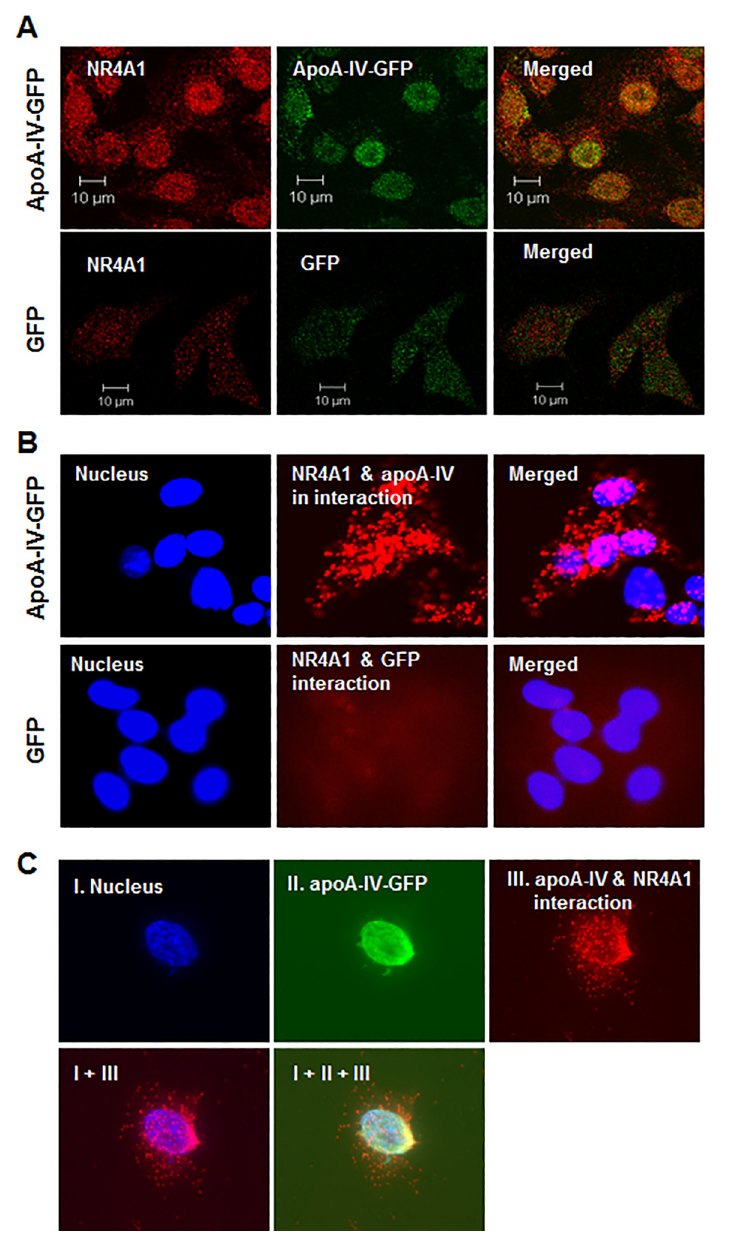
Fig 1. Colocalization of apoA-IV and NR4A1. (A) Subcellular colocalization of apoA-IV and NR4A1 was detected by immunofluorescence. HepG2 cells were transfected with the human NR4A1 expression plasmid for 48 h, and treated with r-h-apoA-IV-GFP (20 μ g/mL) or GFP protein (negative control) for 2 h. The cells were probed with rabbit anti-human NR4A1 and mouse anti-GFP primary antibodies, followed by Alex Flour- 594-conjugated goat anti-rabbit (red) and FITC-conjugated goat anti-mouse secondary antibodies, respectively. The cells were examined using a Zeiss LSM-510 confocal fluorescence microscope. (B and C) Colocalization of apoA-IV and NR4A1 was confirmed by PLA (Materials and Methods). (B) HepG2 cells and (C) HEK-293 cells were transfected as described above for immunofluorescence. The PLA was performed using anti-NR4A1 and anti-GFP primary antibodies, generating fluorescent red foci when examined using a Zeiss Axiovert 200 fluorescence microscope, which indicated the presence of both NR4A1 and r-h- apoA-IV-GFP in close proximity. The cells were counterstained with DAPI (blue) to visualize the nucleus.